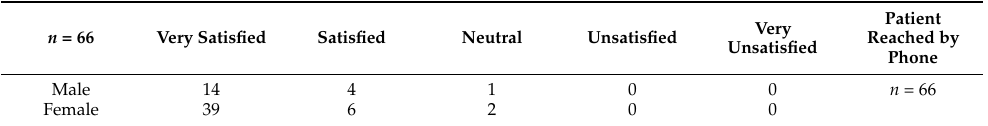
Table 7. Follow-up of the patients: satisfaction today (recovery and reintegration into everyday life after surgery).